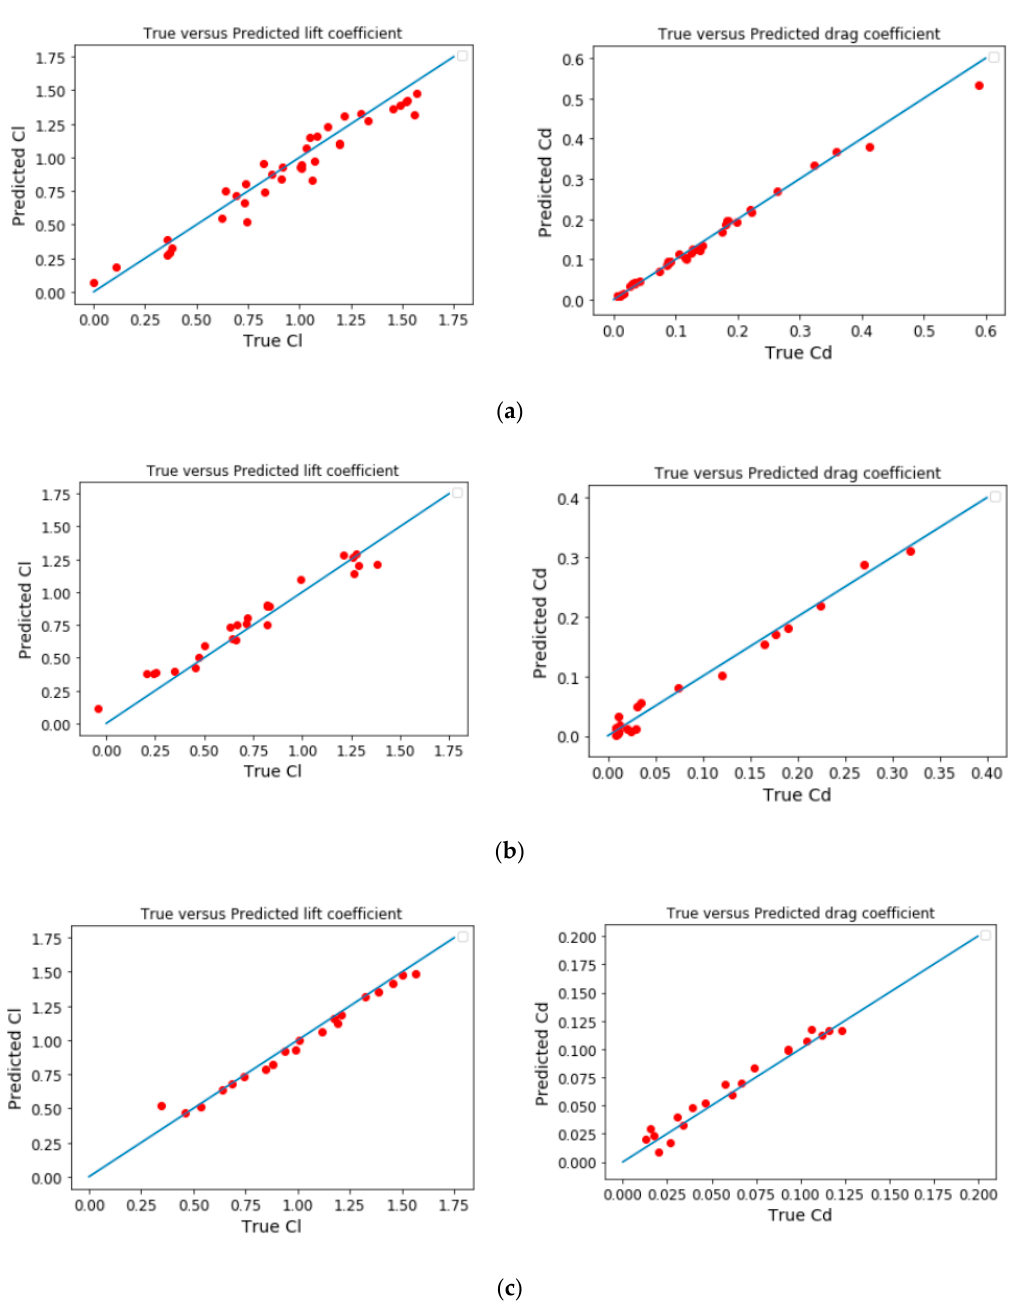
Figure 10. True vs. predicted coe ffi cient values with SVR method: NACA0012 ( a ) RAE2822 ( b ) and DPW ( c ) databases (left: lift coe ffi cient, right: drag coe ffi